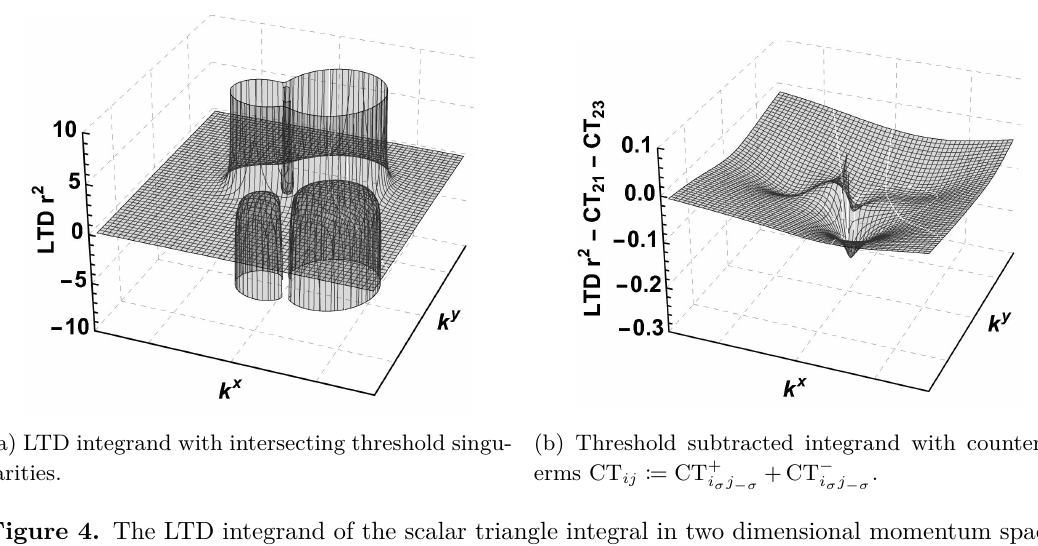
Figure 4. The LTD integrand of the scalar triangle integral in two dimensional momentum space featuring two intersecting E-surfaces in (a) and the corresponding subtracted integrand according to eq. (3.31) in (b). The subtracted integrand is free of poles and can be directly evaluated with Monte Carlo numerical integration. The fine elliptic and hyperbolic lines are artefacts of numerical instabilities in the local cancellations between the LTD integrand and the E-surface counterterms and in the dual cancellations of